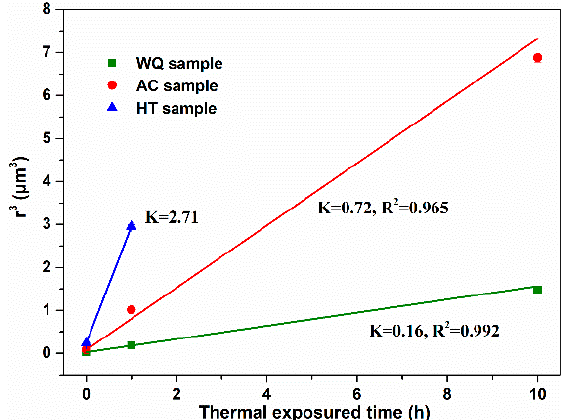
Figure 17. Plots of precipitates size ( r 3 ) vs. time ( t ) for γ′ phases during thermal exposure at 1100 °C, the coefficient of determination ( R 2 ) were also labeled.